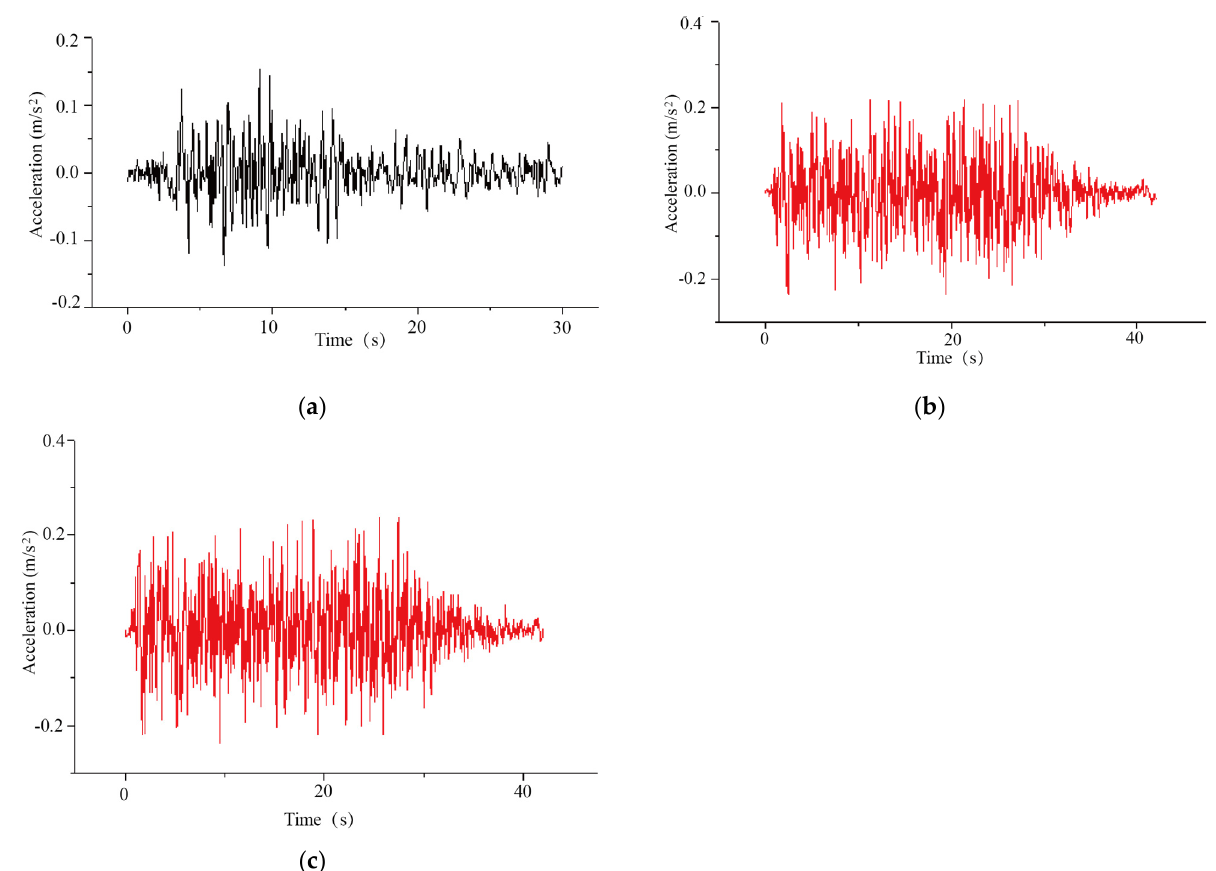
Figure 9. Acceleration time history curve of an E2 earthquake. ( a ) The first acceleration time history curve. ( b ) The second acceleration time history curve. ( c ) The third acceleration time history curve.